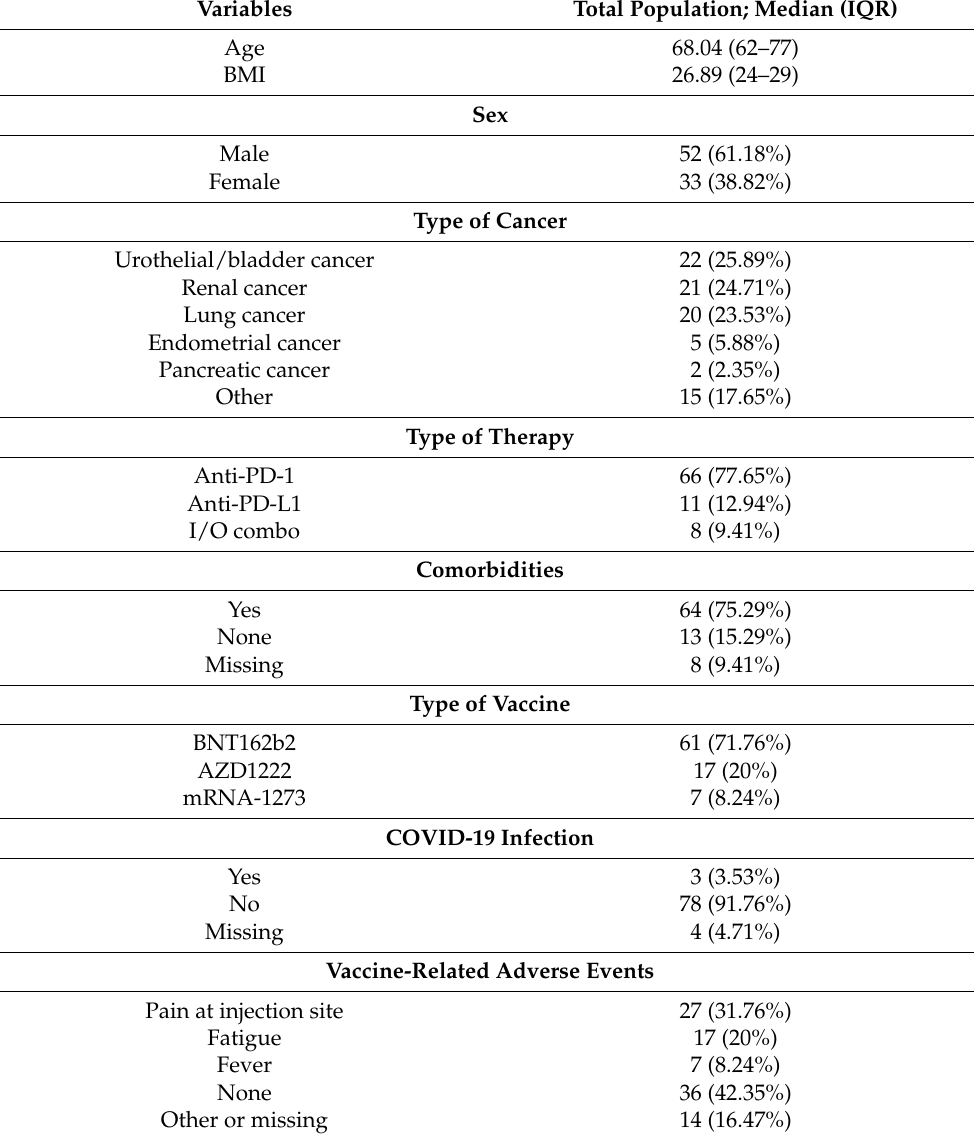
Table 1. Baseline patient